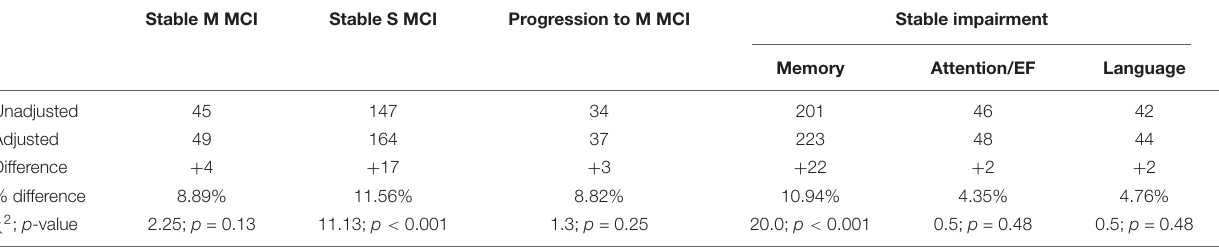
TABLE 3 | Impact of practice effects on classification stability and progression.